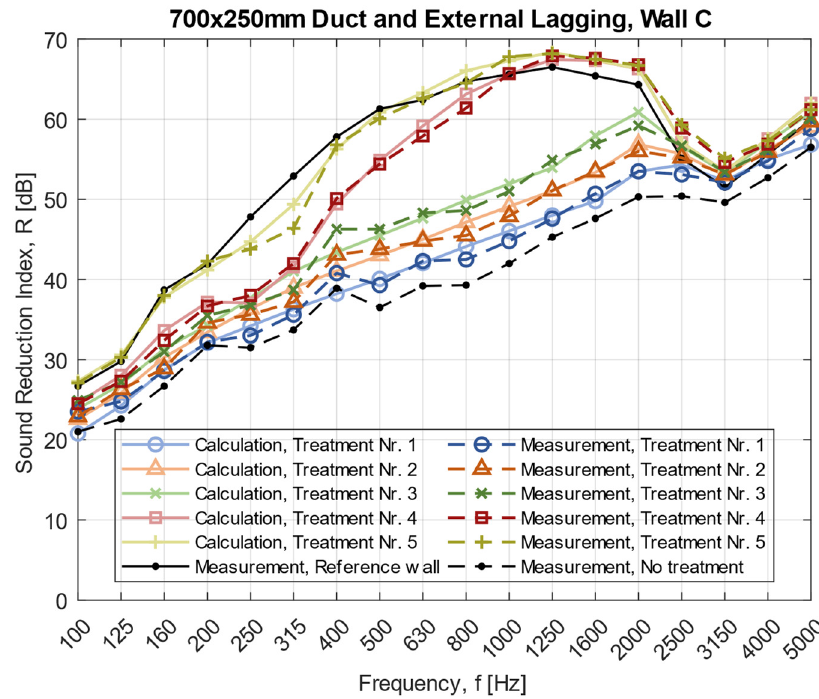
Figure 8. Theoretical models compared to measurements with external lagging as acoustic treatment. Ventilation duct with dimension: 700 × 250 mm through wall C with a sound reduction index of R w = 54 dB. External lagging is mounted at partial lengths of 0.6–1.8 m (Treatment 1–3) and full length (Treatment 4 and 5) with 50 mm and 100 mm stone wool, density of 100 kg/m 3 , closest to the wall.